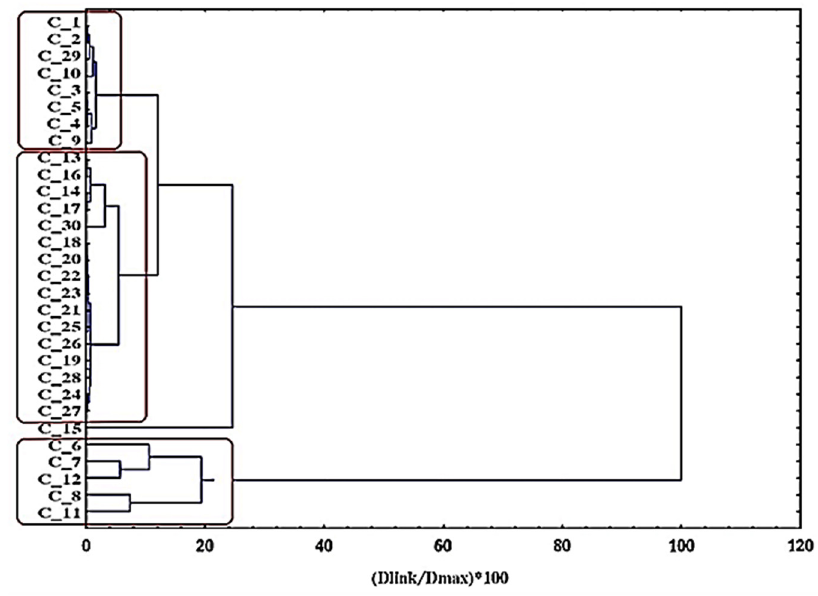
Figure 8. Hierarchical dendrogram for 30 objects (iron oxide nanocrystal clusters) obtained using Ward’s hierarchical clustering method.